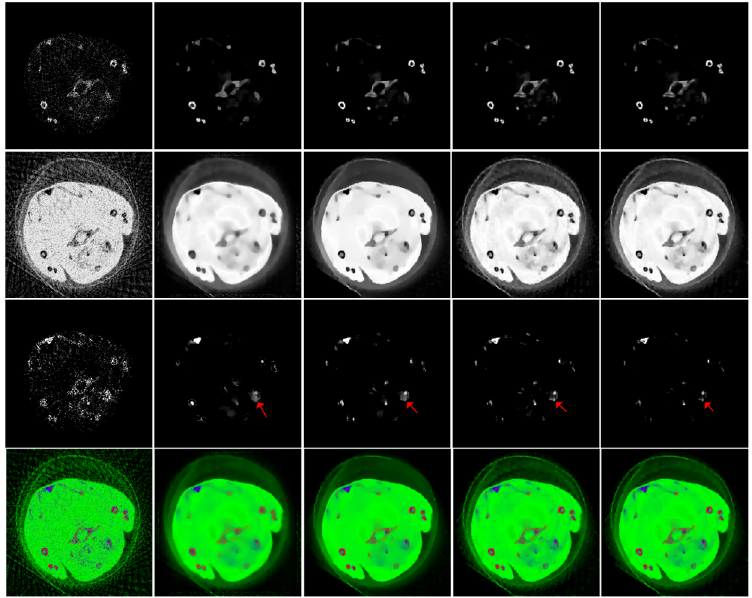
Figure 10. The gradient images from 60 projections. The first row is the first channel and the second Figure 11. Material decomposition results from 60 views. From top to bottom, the first three rows row is the 13th channel. The first column is an image reconstructed from full projections using the are the decomposed bone, soft tissues, and GNP components, respectively. The fourth row is the FBP algorithm ( a ). Other columns are TV ( b ), TV + LR ( c ), TDL ( d ), and our algorithm ( e ). The dis- color representation of the corresponding basic materials. From left to right, the columns are FBP, play windows are [0, 0.02] cm − 1 . TV, TVLR, TDL, and our algorithm.